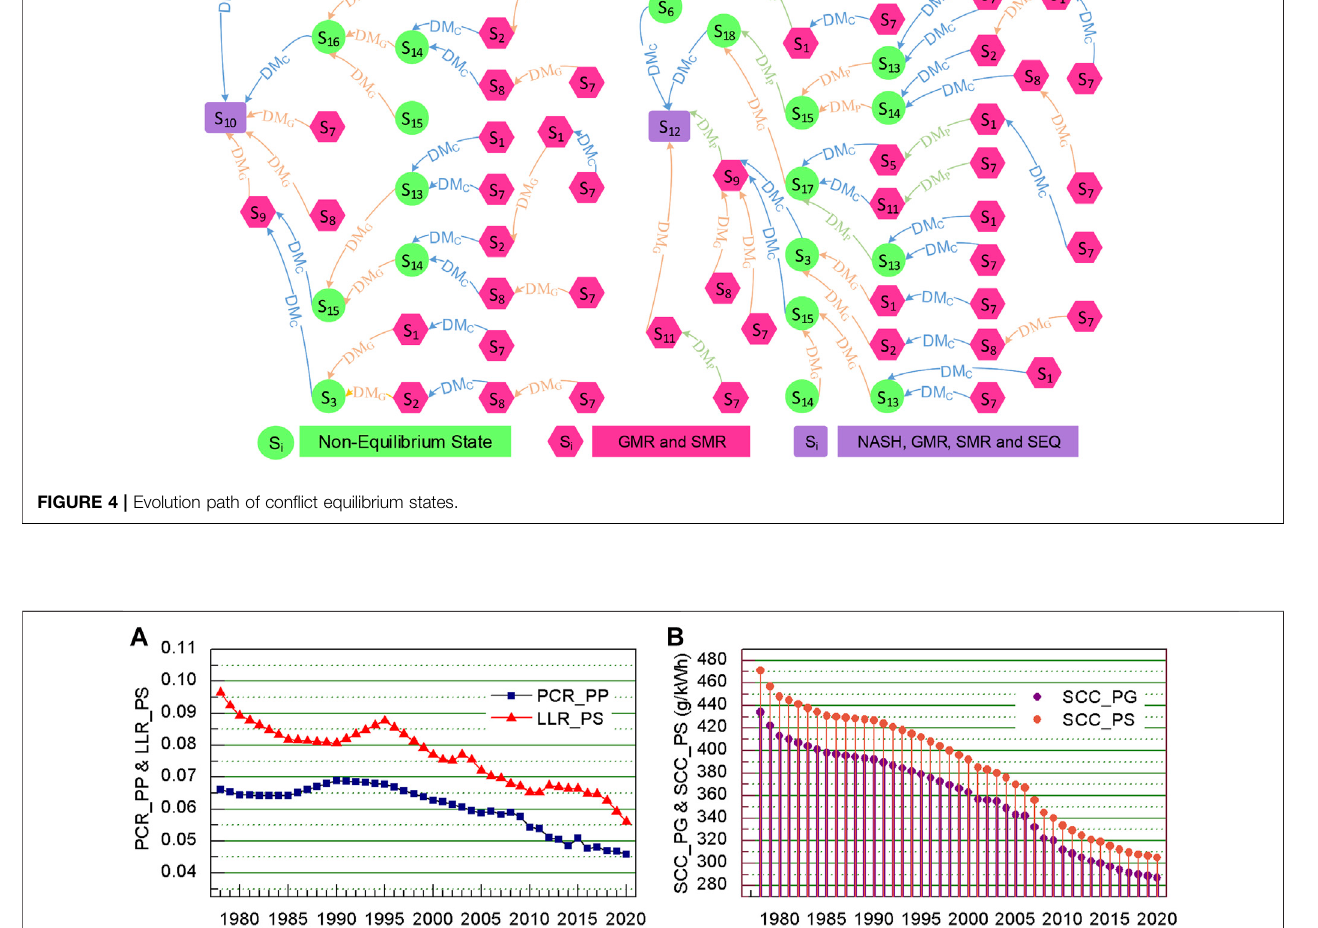
Frontiers in Environmental Science |